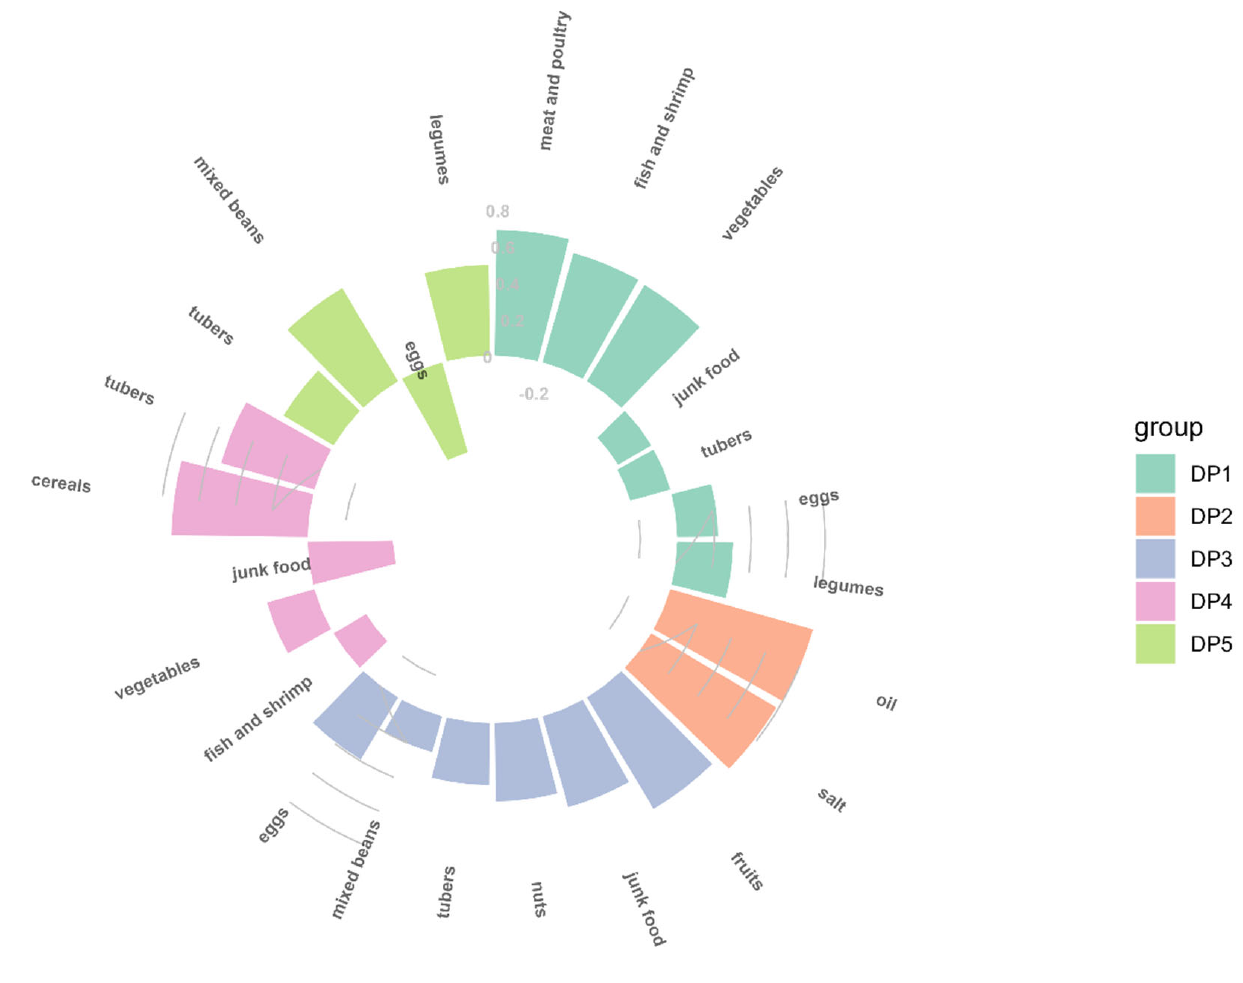
Figure 1. Factor loading of food items in each dietary pattern. The results of the distribution of five DPs are presented in Table 2. Among children and adolescents aged 7–17, the percentages of DP1 to DP5 were 19.24%, 16.32%, 19.39%, 24.38% and 20.66%, respectively. Obviously, DP4 (cereals and tubers pattern) was the main DP in all subjects. However, DP1 (animal product and vegetable pattern) appeared in the participants living in urban areas. DP5 (beans pattern) appeared in the participants whose Engel’s coefficient was greater than 40% and participants who were